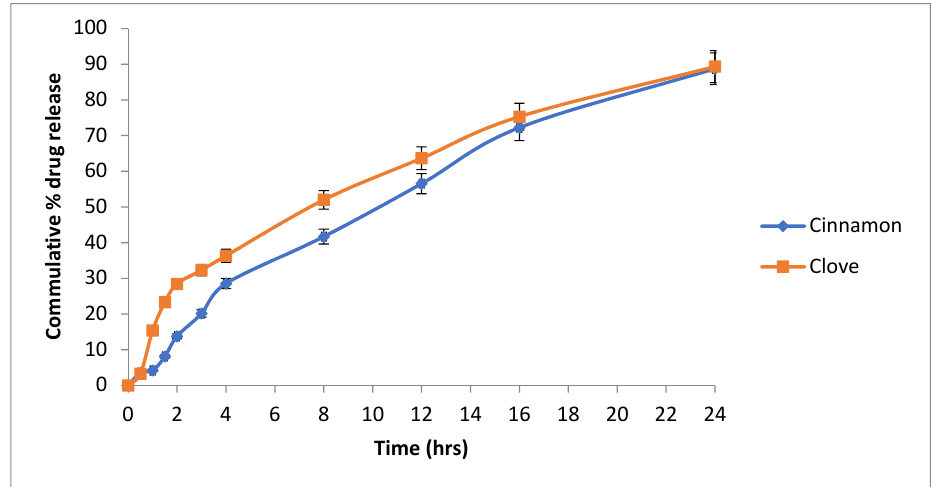
Figure 8. Release profile of the cinnamaldehyde and eugenol from the optimized formulation of nanoemulsion.